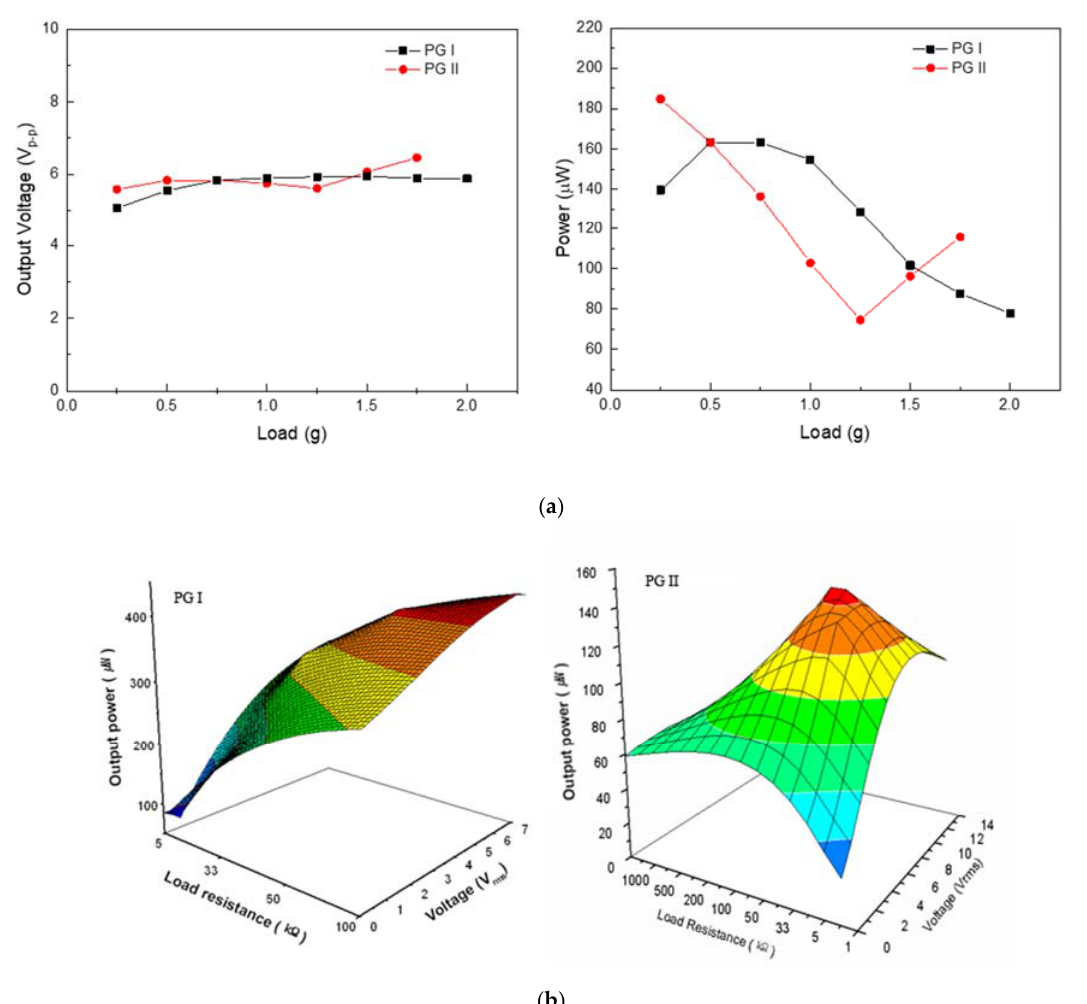
Figure 3. Output voltage and power of piezoelectric generator as a function of payload. ( a ) Output voltage and power versus load at 37 and 52 Hz; ( b ) Output power–voltage–load resistance of PG I at 37 Hz and PG II at 52 Hz.